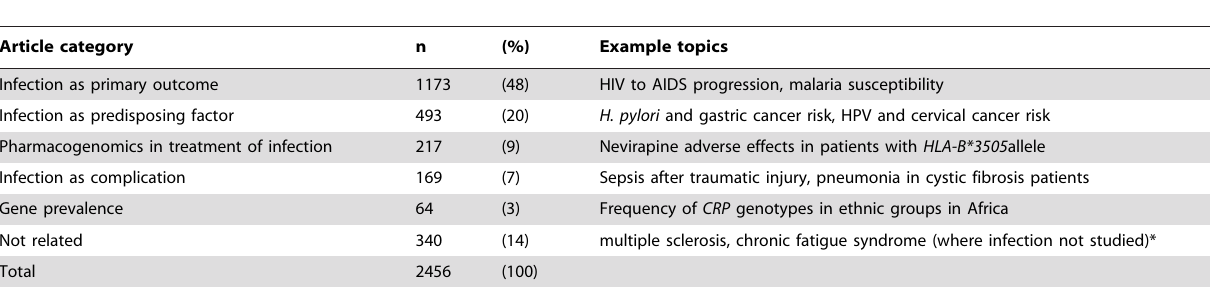
Table 1. Articles related to infectious diseases by studied outcome, HuGE Navigator, 2006–2010.